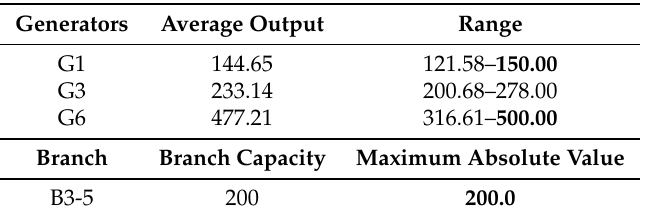
Table 7. Power output from generators and tight constraint on power flow of transmission line in case 3